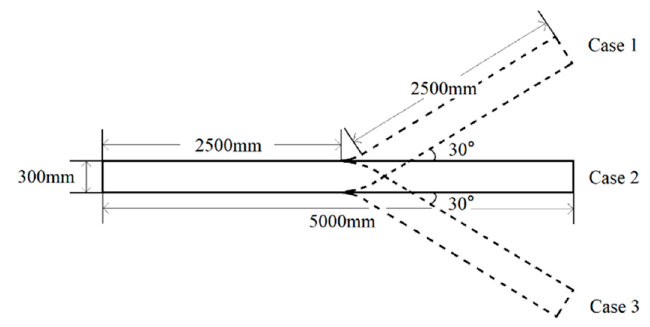
Figure 1. Physical model of a natural gas pipeline.